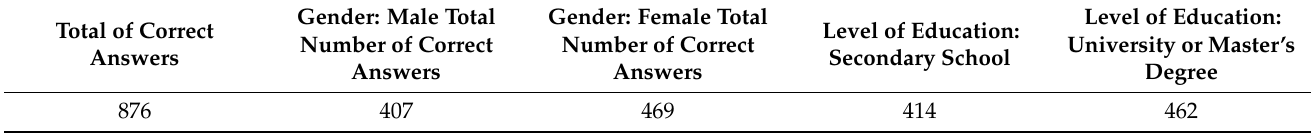
Table 14. Posttest 2 results regarding gender and level of education.